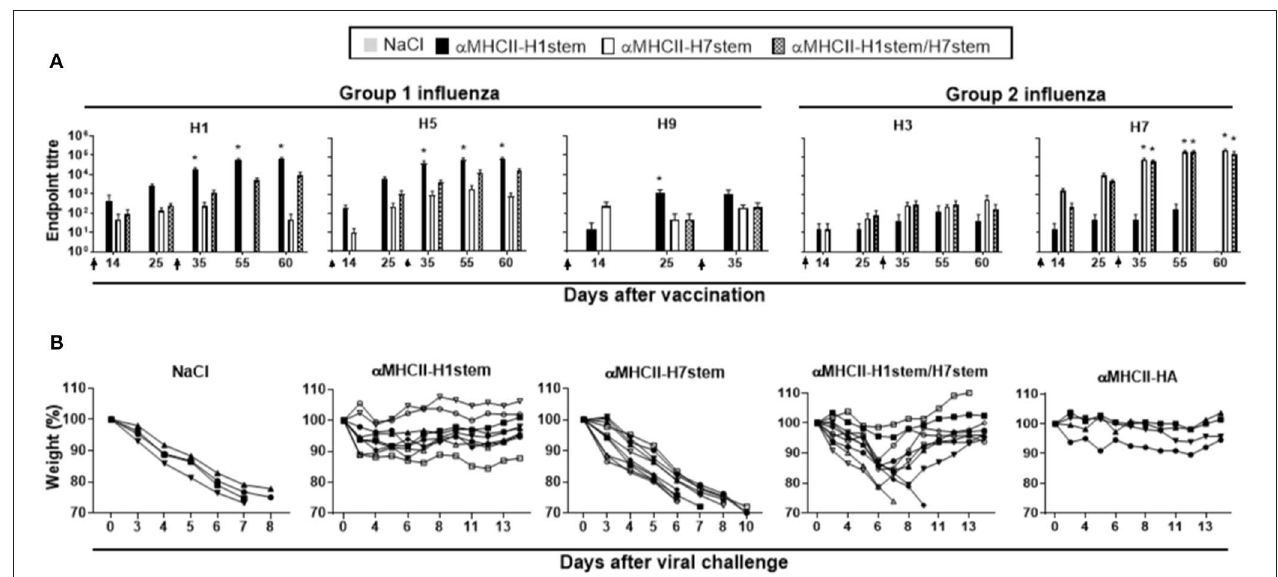
FIGURE 5 | Protection against influenza H1N1 in F1 mice of BALB/c and CR9114 gH knock-in. (A) F1 of BALB/c and knock-in 9,114 gH mice ( n = 10 mice/group, n = 4 mice/group for NaCl and α MHCII-HA) were immunized twice on days 0 and 28, as indicated by arrows, and sera analyzed for development of IgG responses against recombinant HA from PR8 (H1N1), A/Hong Kong/1/1968 (H3N2), A/Hong Kong/483/97 (H5N1), A/Shanghai/1/2013 (H7N9), and A/Hong Kong/1073/99 (H9N2). Values given are mean ± SEM. * p < 0.05 as compared to NaCl (two-way ANOVA and Bonferroni post-test). (B) At day 59 after vaccination, mice were challenged with 2.5 × LD50 of influenza A/PR/8/1934 (H1N1) and monitored for weight.